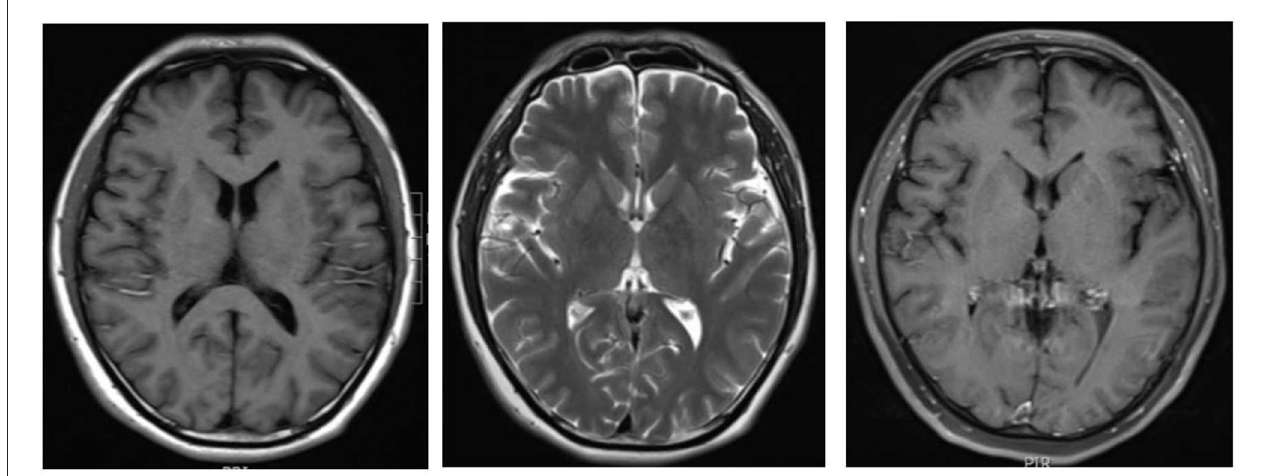
FIGURE 2 | Repeated mNGS of blood results of the patient. The coverage and proportion of Coxiella burnetii detected by mNGS in blood (A) and reexamined mNGS in blood (B) . mNGS, metagenomics next-generation sequencing.